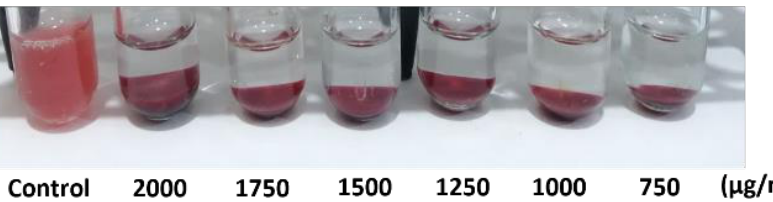
Figure 10. Hemolysis percentage of Ni 1 − x Co x Fe 2 O 4 @Methionine@PEG NPs with a positive control at different concentrations.